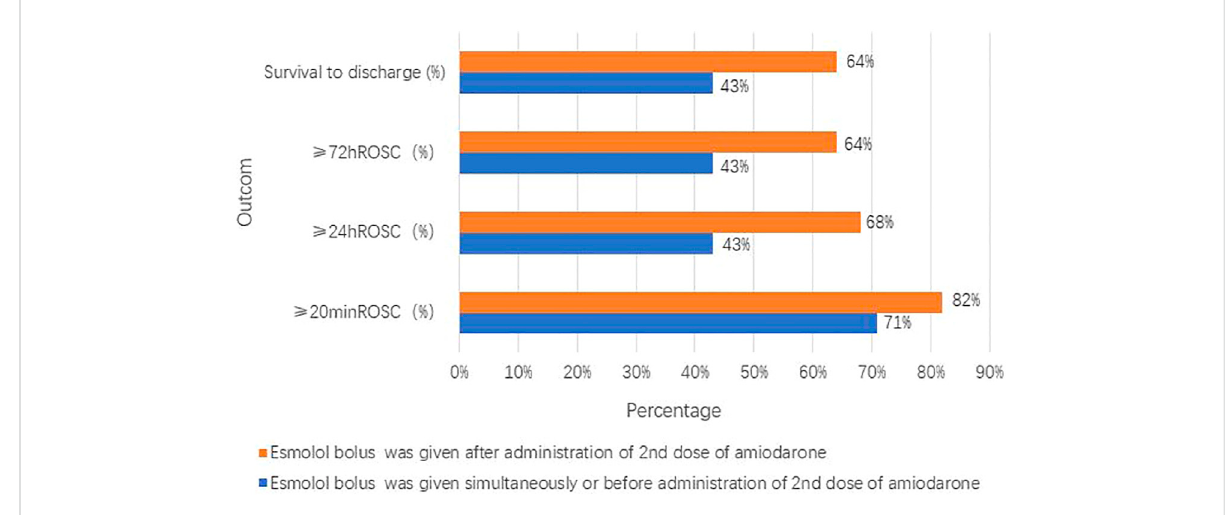
FIGURE 4 Groups with different timings of esmolol administration compared with the timing of amiodarone administration.